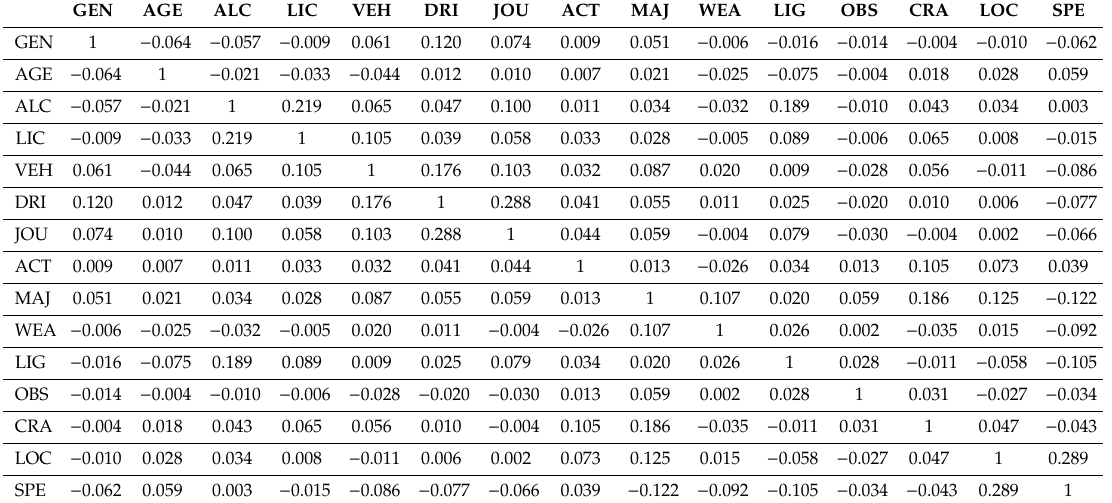
Table 1. Metric of multicollinearity of 15 correlated variables. GEN: driver gender; AGE: driver